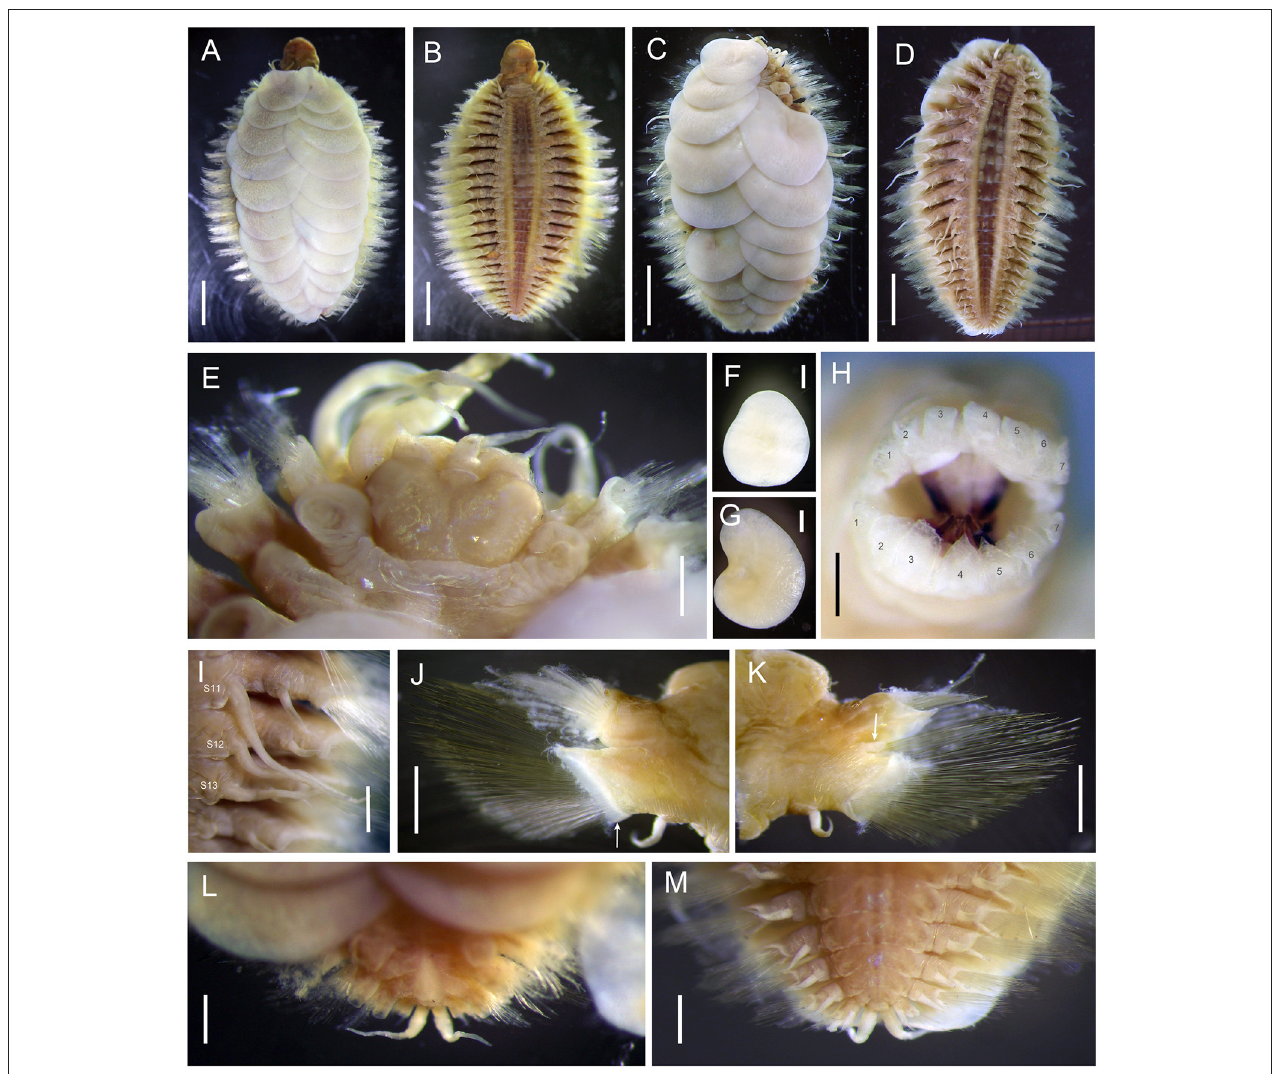
FIGURE 7 | Lepidonotopodium okinawae . (A,B,E,F,G) Specimen 5; (C,D) Allotype; (H) Specimen 6; (J,K) Specimen 10; (I,L,M) Specimen 1. (A) dorsal view of female. (B) ventral view of female. (C) dorsal view of male. (D) ventral view of male. (E) dorsal view of anterior part. (F) first elytra. (G) second elytra. (H) top view of extended pharynx. (I) ventral view of segments 11–13 (male). (J) anterior view of parapodium (segment 9). The arrow indicates the membrane-like edge. (K) posterior view of parapodium (segment 9). The arrow indicates the tubular attachment on the dorsal base of neuropodia. (L) dorsal view of posterior part. (M) ventral view of posterior part. Scale bar: (A–D) 2mm; (E) 1mm; (F,G,I,J,K,L,M) 0.5mm; (H)